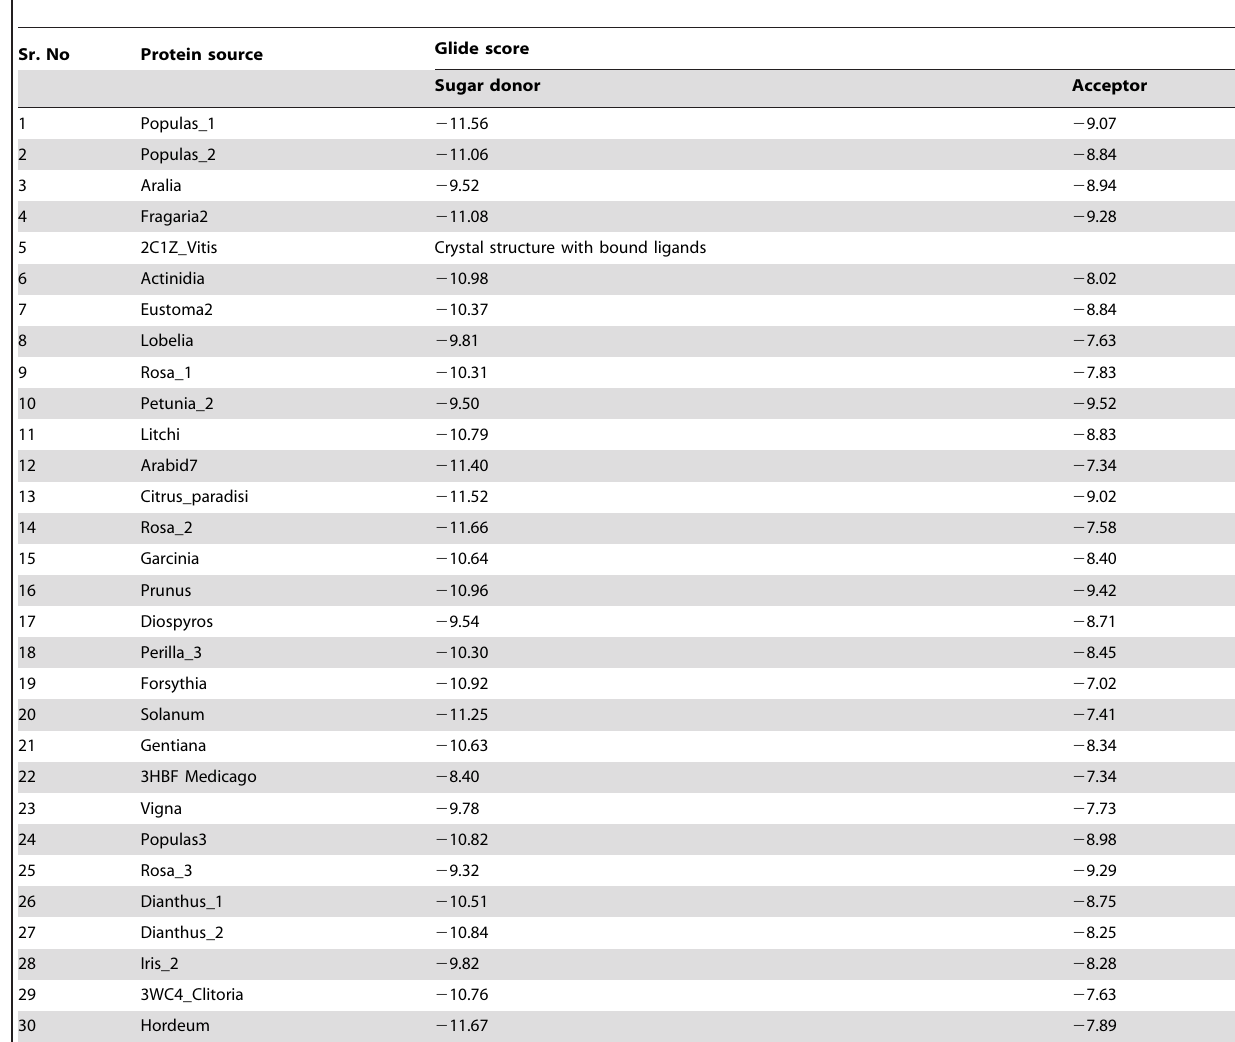
Table 2. Docking statistics (Glide score values) of sugar donor and acceptor substrates for 30 F3GT proteins.